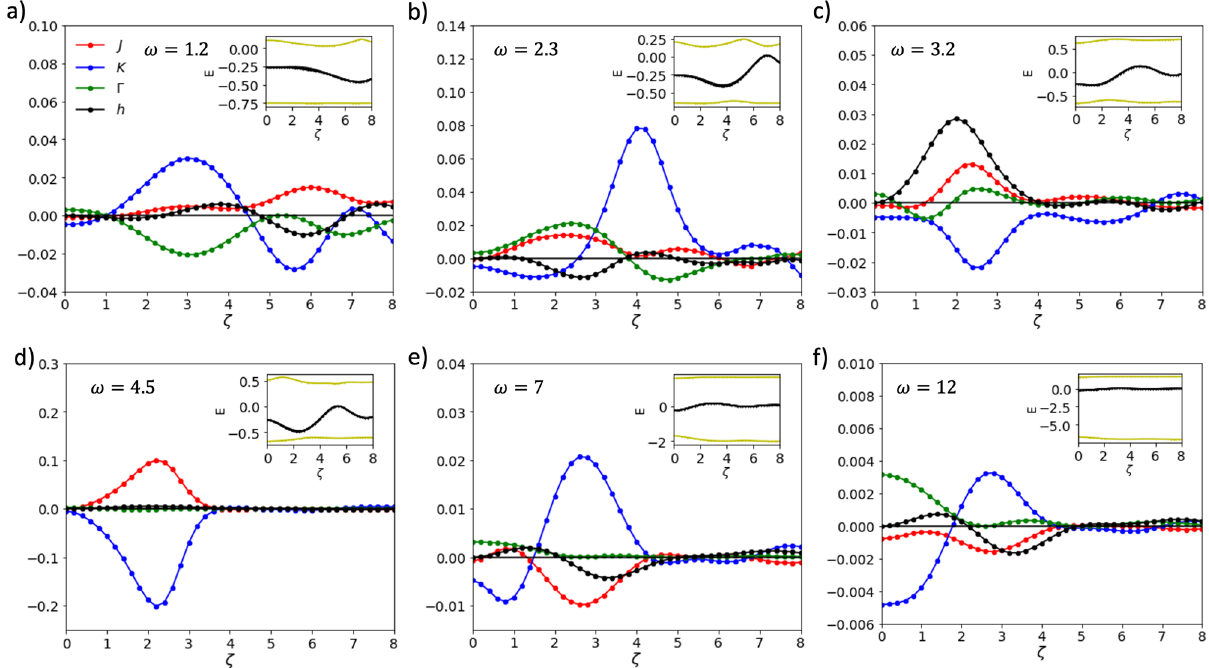
Fig. 3 Tuning spin-exchange couplings ( J , K , Γ ) and emergent magnetic fi eld ( h ) in model with ligands. Panels a – f show J , K , Γ , h as a function of drive strength ( ζ ) for drive frequency ω = 1.2, 2.3, 3.2, 4.5, 7, and 12, respectively. Inset in each panel shows the energy levels (E) in the vicinity of m = 0 Floquet singly occupied states. The black line indicates the states with the largest weights on the singly occupied con fi gurations. Notice that the y -axis are plotted in the different intervals to highlight the relative strength between different